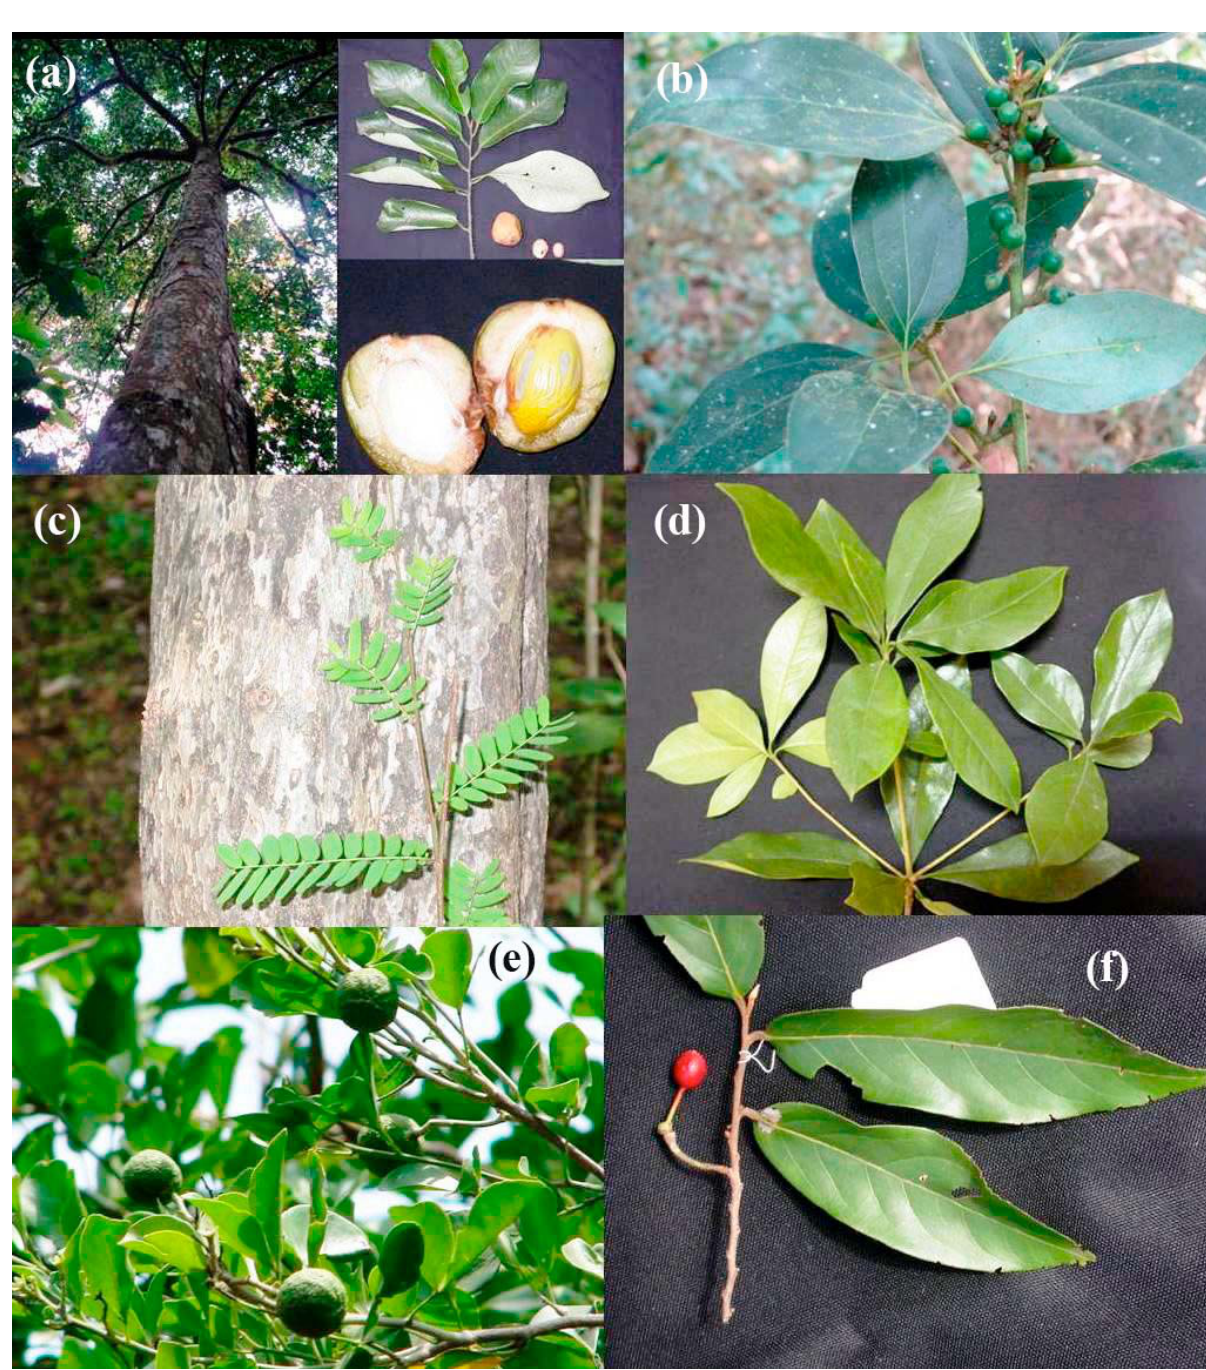
Figure 15. a) Myristica dactyloides (Myristicaceae); b) Neolitsea scrobiculata (Lauraceae); c) Phyllanthus polyphyllus (Euphorbiaceae); d) Pittosporum neelgherrense (Pittosporaceae); e) Pleiospermium alatum (Rutaceae); f) Polyalthia cerasoides (Annonaceae). Photo by L. Arul Pragasan & N.